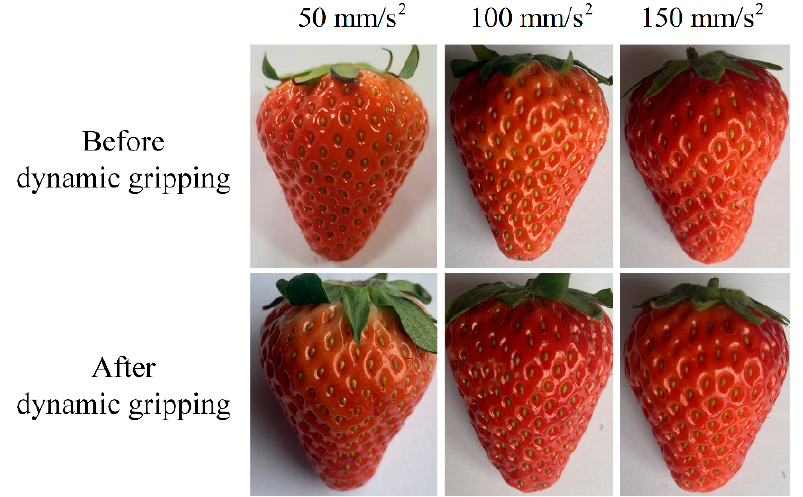
Figure 15. The comparison of the damage of the strawberry before and after the dynamic gripping.